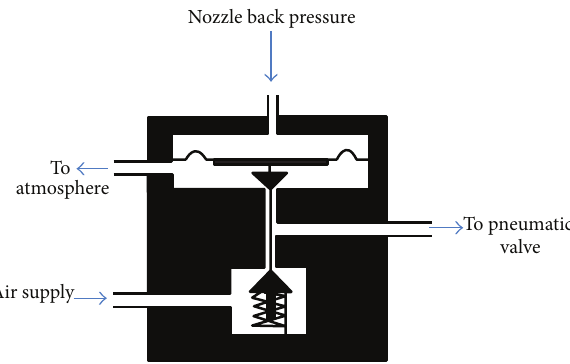
Figure 2: A simple model of bleed-type